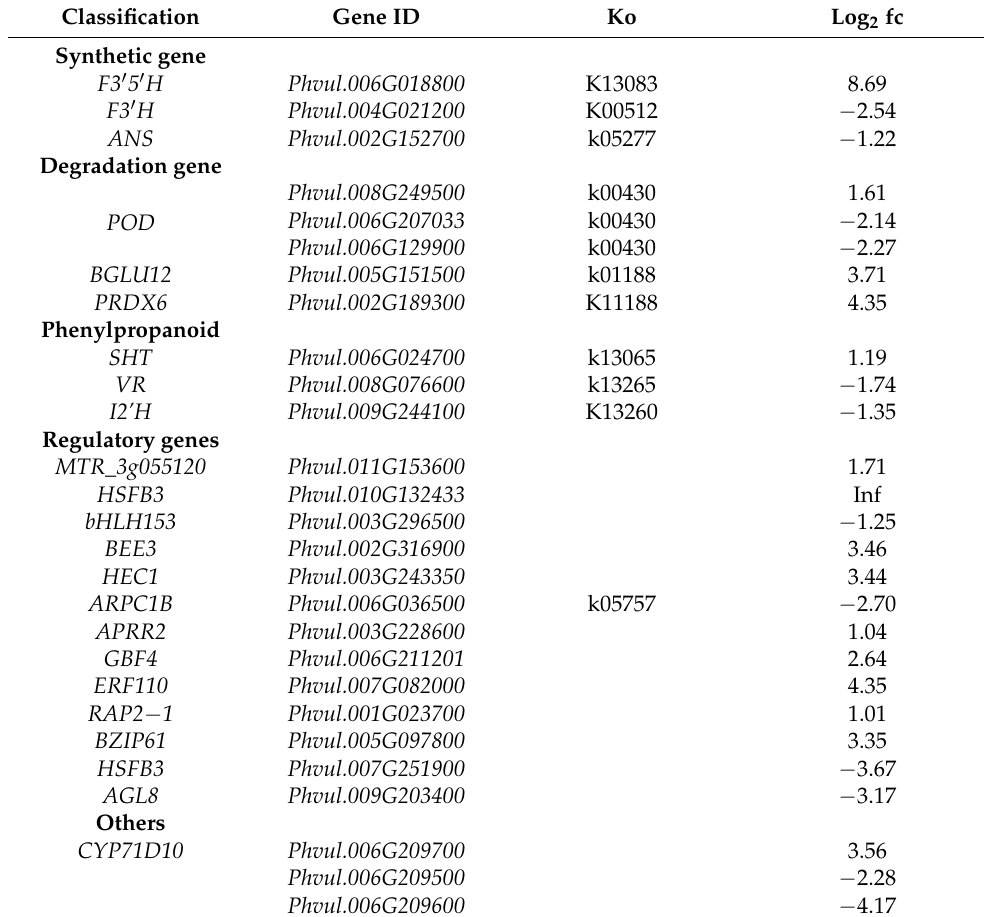
Table 2. Differentially expressed genes involved in anthocyanin